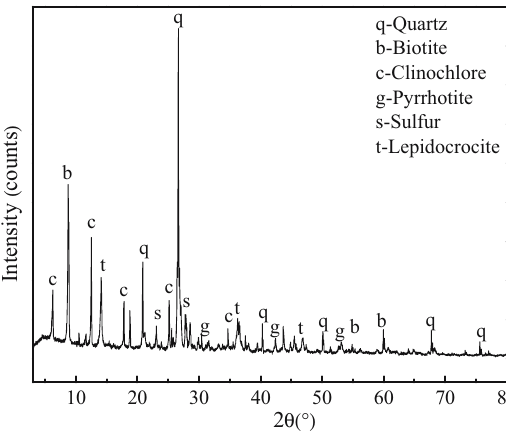
Figure 1: XRD pattern of the copper ore